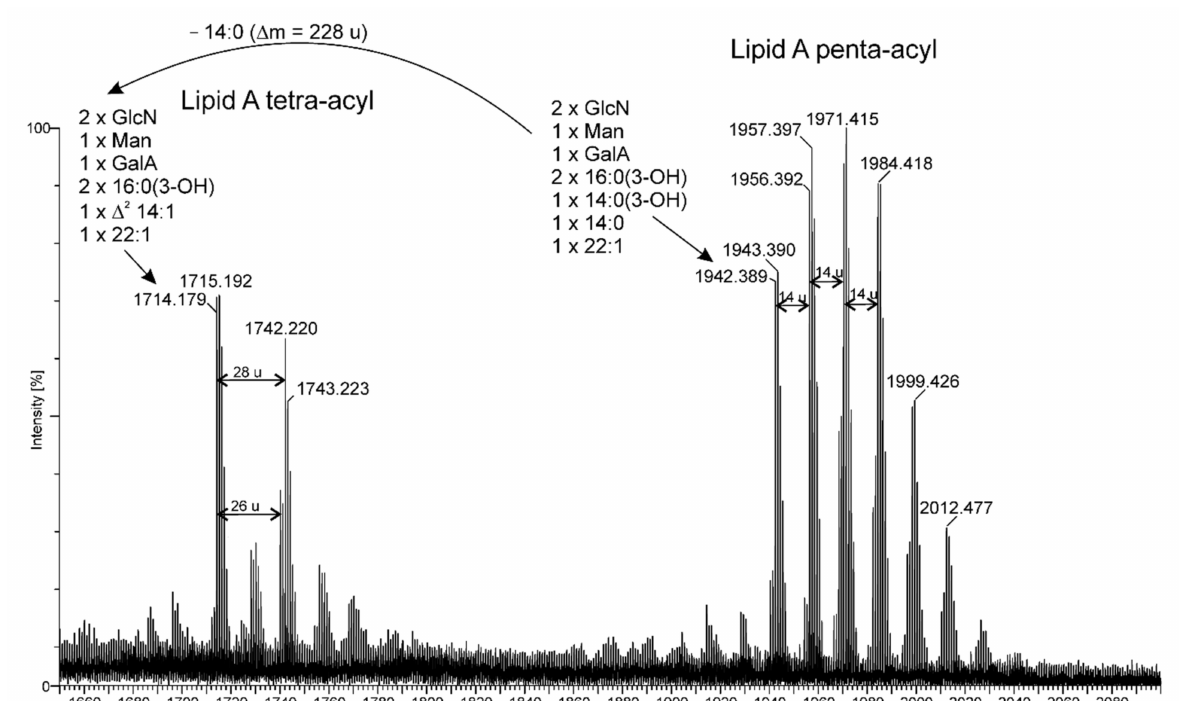
Figure 4. ESI-MS mass spectrum in the negative ion mode of native Rv lipid A.